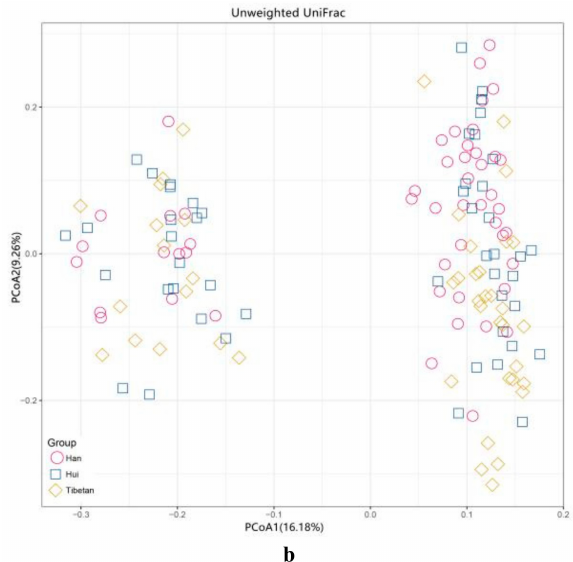
Figure 4. Principal coordinate analysis (PCoA) derived from ( a ) weighted and ( b ) unweighted UniFrac distances among samples of the three ethnic groups. The percent of variation explained by each axis is shown in square brackets, with Han samples represented by purple circles, Hui as blue squares, and Tibetan as yellow squares.